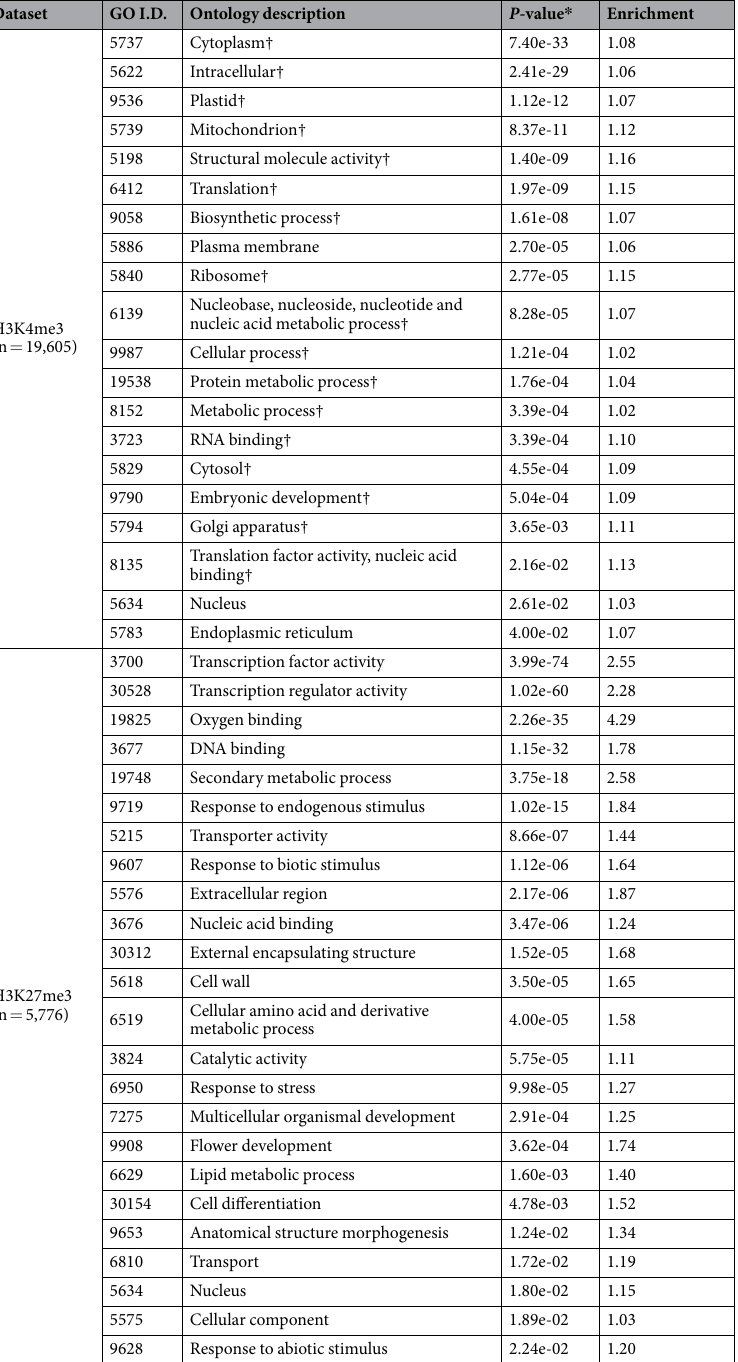
Table 1. GOSlim plant gene ontologies overrepresented among H3K4me3- and H3K27me3-modified genes. * Benjamini & Hochberg-corrected value. † GO terms that were underrepresented among H3K27-trimethylated